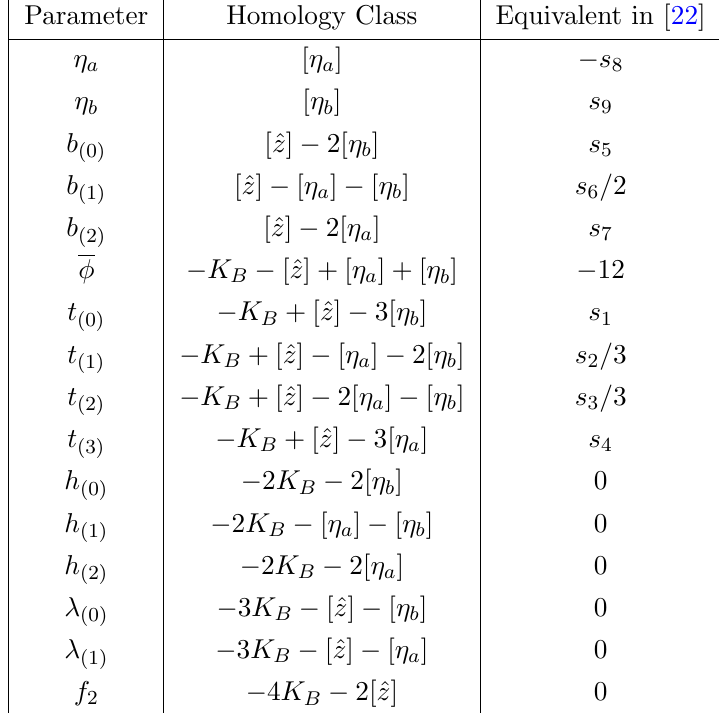
Table 1 . Parameters for the q = 3 model. The center column lists the homology classes of the parameters in terms of the homology classes for (cid:17) a , (cid:17) b , and ^ z . K B refers to the canonical class of the base. The rightmost column gives the dictionary between the parameters used here and those used in the previous model in